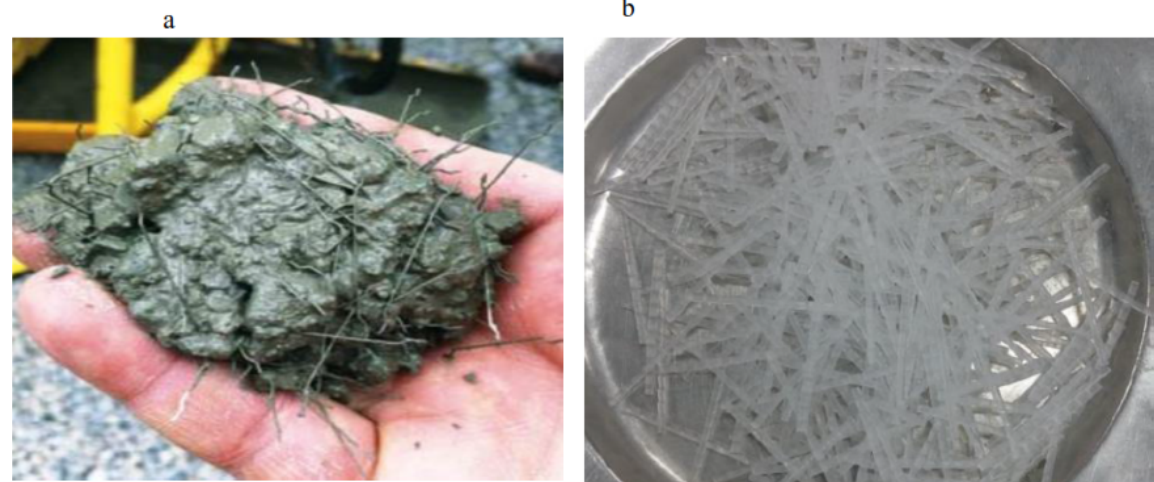
Figure 1: Fiber reinforcements used in this study (a. hooked steel fibers; b. polymer fibers)